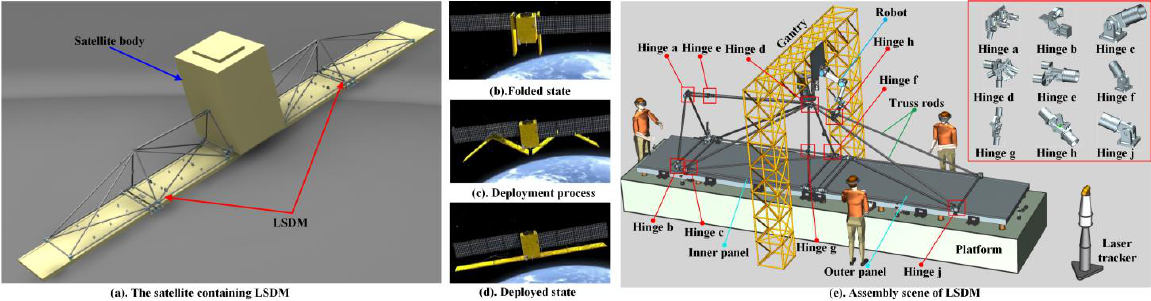
Figure 1. The LSDM of a satellite and its assembly